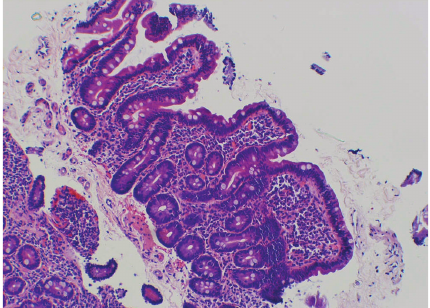
Figure 2: Duodenal biopsy showing mild villous blunting, crypt hyperplasia, and intraepithelial lymphocytes characteristic of celiac